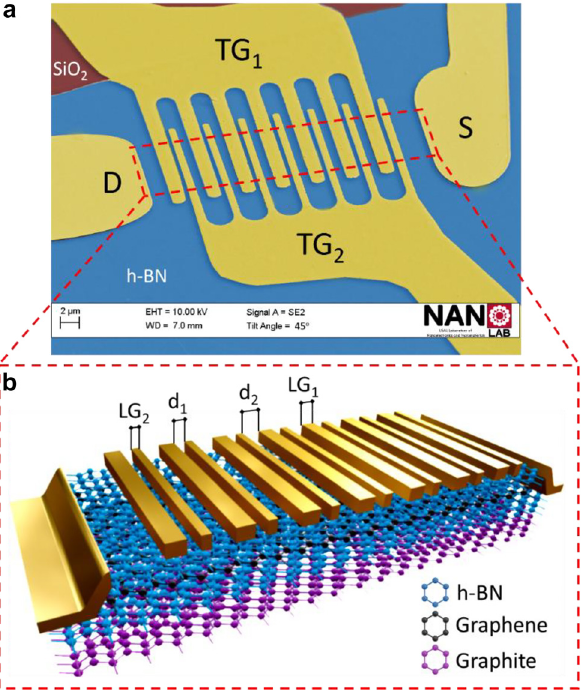
Figure 1: ADGG graphene-based THz detector. (a) False colour SEM tilted image of the fabricated ADGG-GTeraFET where drain (D), source (S), top gate 1 (TG 1 ), top gate 2 (TG 2 ) terminals are labeled. Top h-BN and SiO 2 are colored in blue and garnet respectively and the red dashed line highlights the edges of the graphene sheet to guide the eye. (b) 3D schematic view (not to scale) of the highlighted red dashed area showing the structure of the fabricated ADGG-GTeraFET consisting of two asymmetrically situated top gates, a monolayer graphene sheet encapsulated betweentwo fl akesofhexagonalboronnitrideandafew-layersthick graphite to be used as the back-gate. Drain and source were fabricated as one-dimensional edge contacts with the graphene